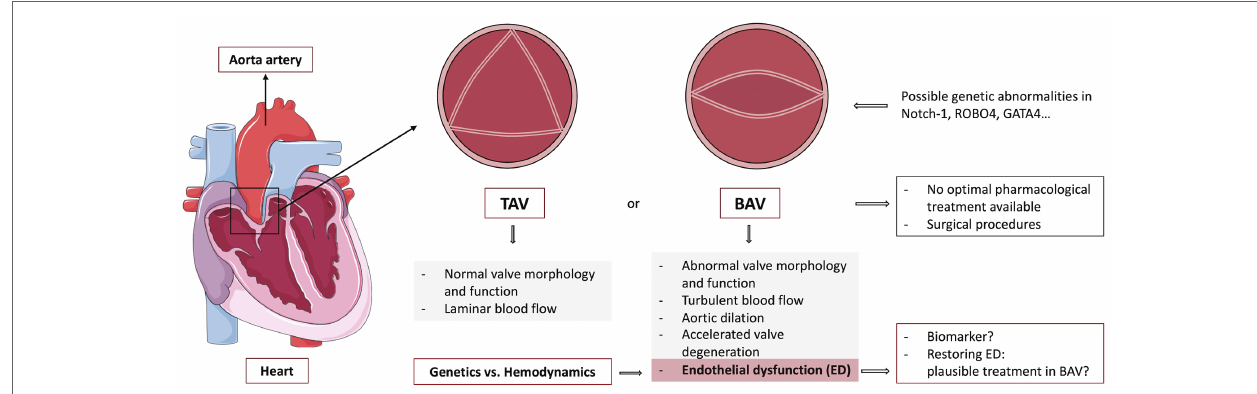
FIGURE 1 | Graphical abstract of the review: a heart is represented at the left, signalizing the aorta, as well as the zone where the aortic valve is found. Different morphologies of this valve are also shown, pointing out the generalities of a healthy tricuspid aortic valve (TAV) and bicuspid aortic valve (BAV) disease. Additionally, endothelial dysfunction (ED) and its importance in BAV disease are also discussed. TAV, Tricuspid aortic valve; BAV, Bicuspid aortic valve; Notch-1, Neurogenic locus Notch homolog protein 1; ROBO4, Roundabout guidance receptor 4; GATA4, GATA binding protein 4. The figure was created by using pictures from Servier Medical Art (http://smart.servier.com/), licensed under a Creative Commons Attribution 3.0 Unported License